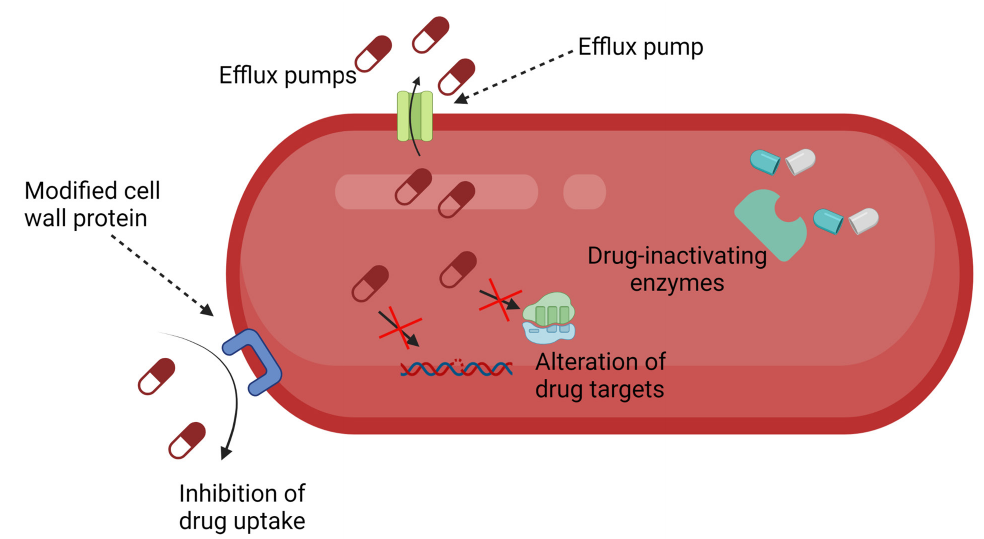
Figure 1A. Mechanisms of bacterial resistance to antibiotics.